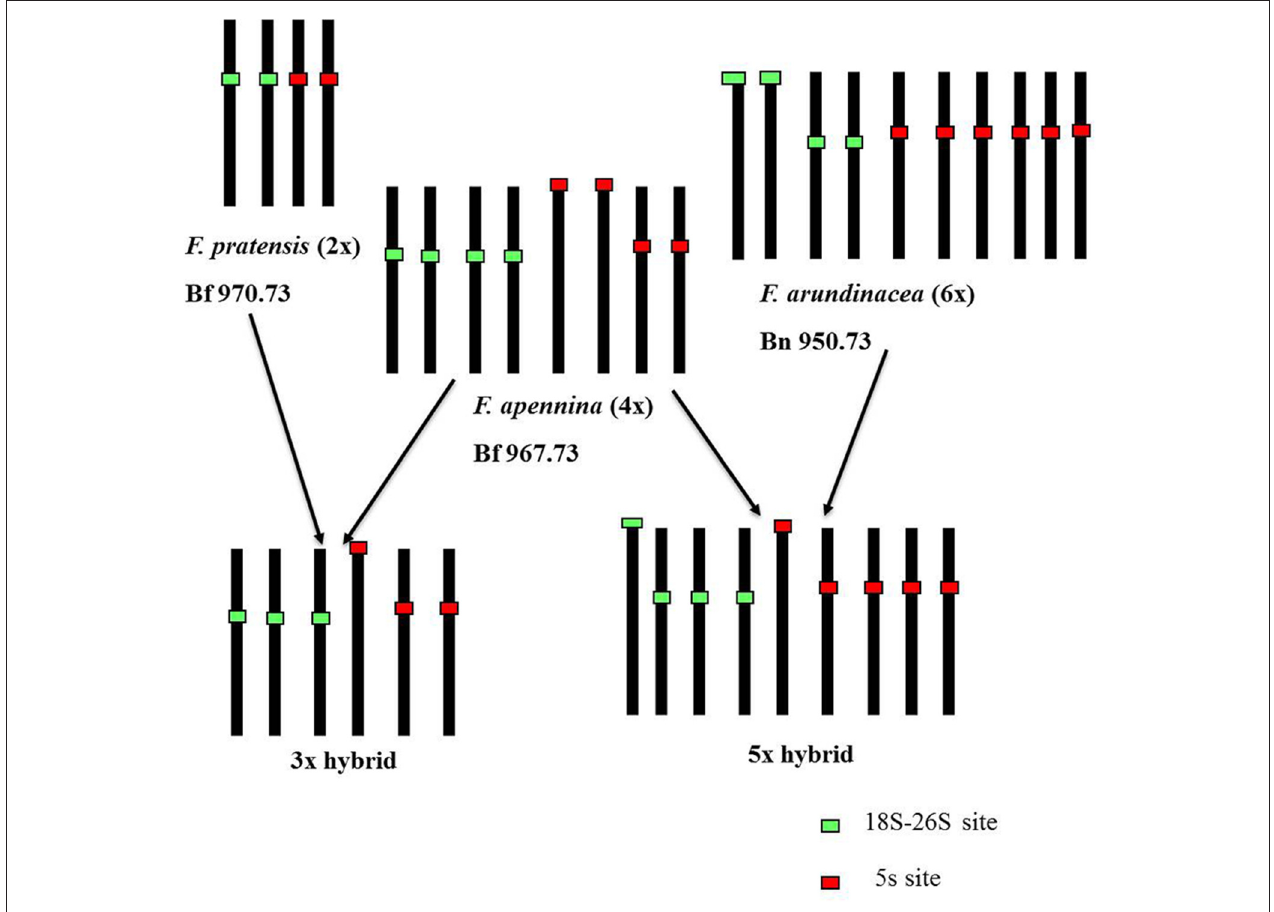
FIGURE 6 | The relationship between the Festuca species and their hybrids based on rDNA